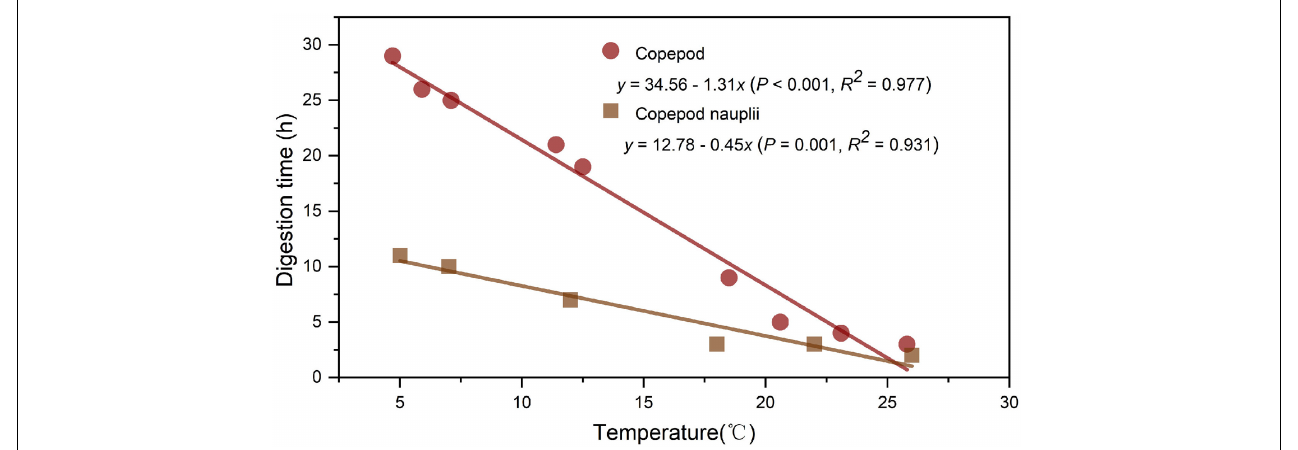
FIGURE 9 | The relationship between temperature and digestion time of copepods and copepod